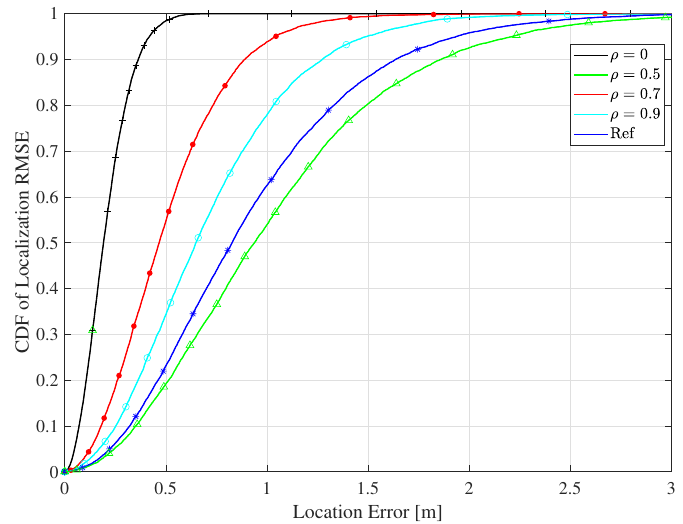
Figure 20. The CDF of the RMSE for the proposed algorithms for different spatial correlation values ρ for the LOS environment and the co-polarized antenna